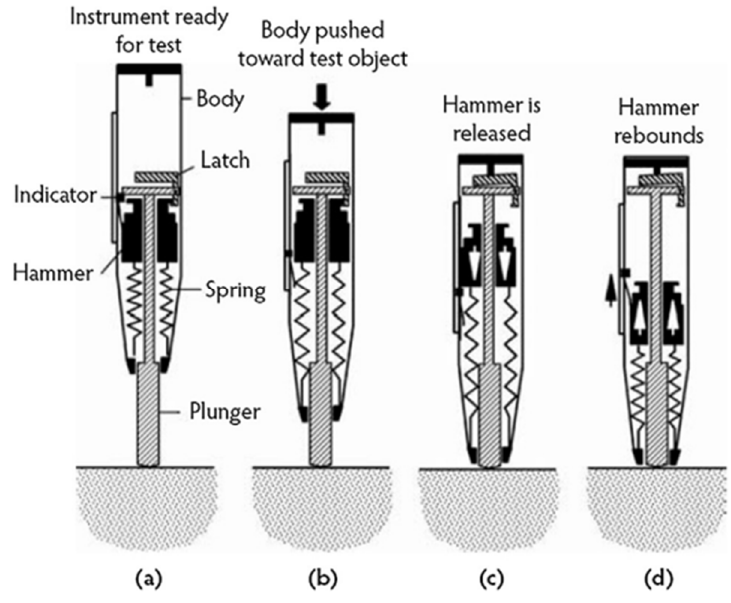
Figure 3. Operation of the rebound